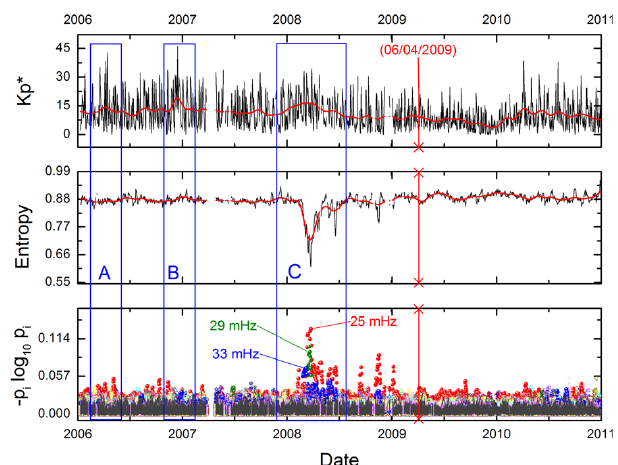
Fig. 3. Time behaviour of daily K p geomagnetic index (top panel; K p ∗ = 10 × K p ) along with that of the total entropy averaged be- tween A r and B r (middle) and of the contributions of individual harmonics to the total entropy (bottom). The red lines in the top and middle panels are 20-day moving averages. The main features, visible in the middle and bottom plots, are the increases in the val- ues of a few harmonics (with frequencies between 25 and 33mHz) with distinctly larger contributions to entropy than the general back- ground of 0.03 units. These increases do not seem to be caused by external magnetic activity. Intervals indicated with A, B and C are useful for comparing increases of K p * with different behaviours of the